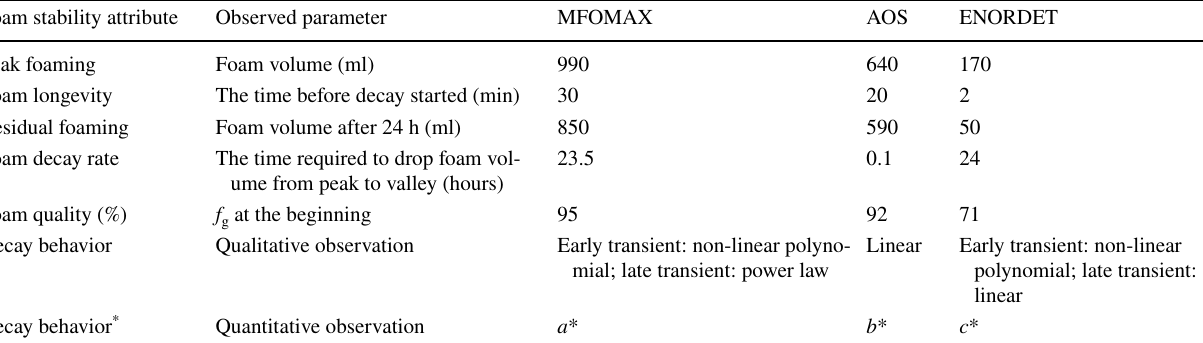
Table 6 Summary of results from bulk foam stability tests